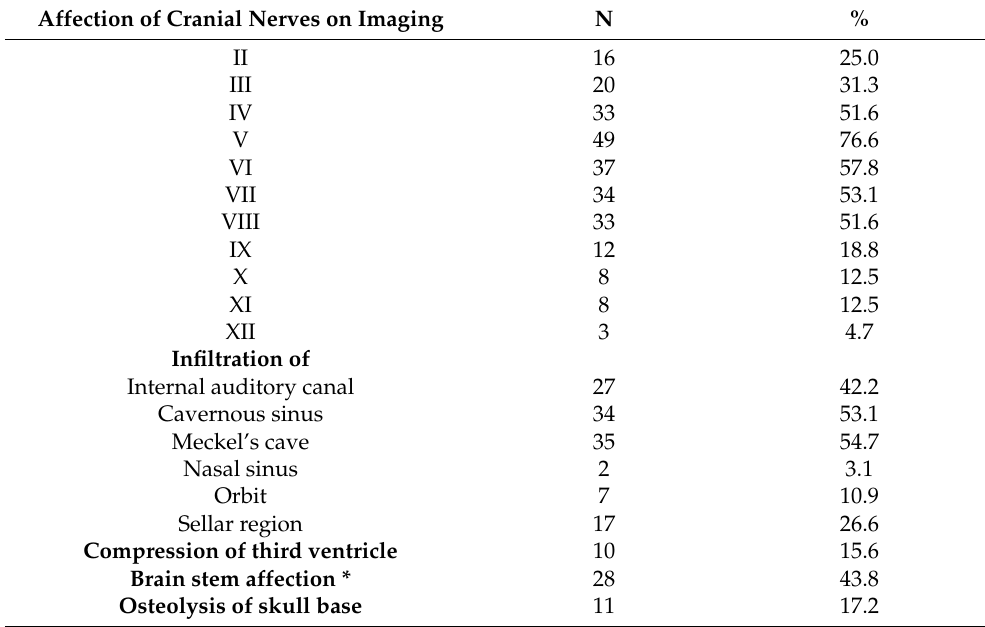
Table 2. Numbers of cases with affiliation of PCM with surrounding structures on preoperative imaging, with or without corresponding symptoms. * determined on preoperative T2 MRI. N, number; %, percentage of entire cohort